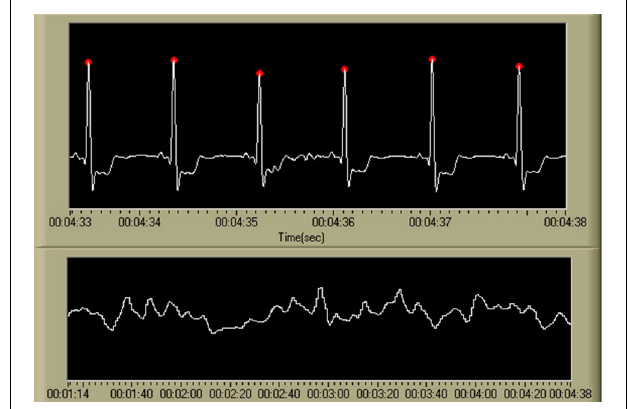
FIGURE 7 | Output of the R-wave detection algorithm (Pan and Tompkins, 1985; Hamilton and Tompkins, 1986) and the resulting IBI time series. Detected R -waves are shown in the first chart using red marking indicators at the apex of each QRS complex. The second chart displays the resulting IBI time series. While not shown on the display, the scale for the ECG time series is [uV], and the IBI time series is visualized as heart rate in beats per minute, or [BPM]. The time scale is in standard HH:MM:SS format.